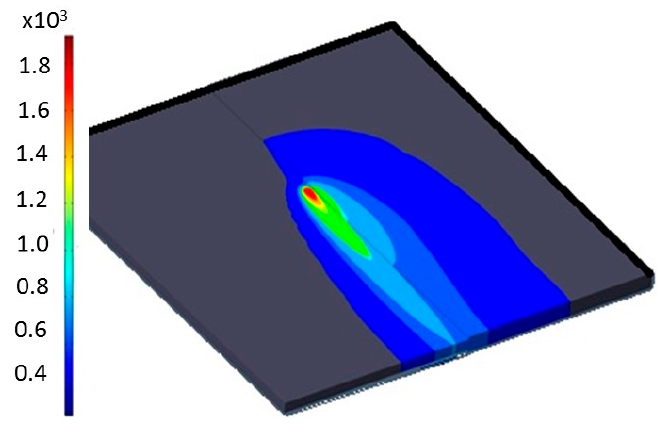
Figure 12. Isometric view of temperature distributions (in Kelvin) using 3D heat source modelling.